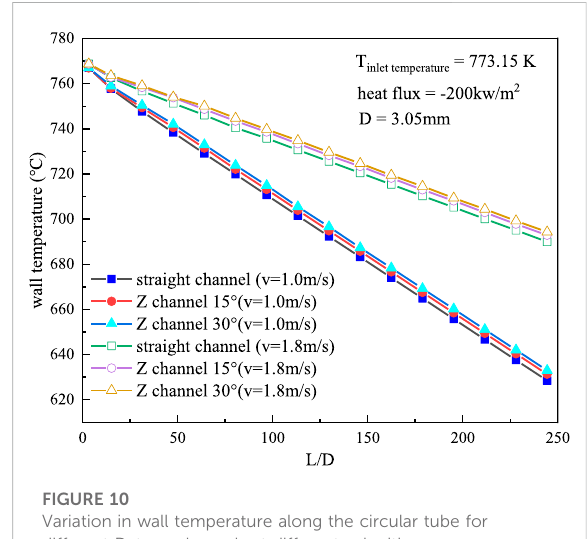
FIGURE 10 Variation in wall temperature along the circular tube for different D-type channels at different velocities.